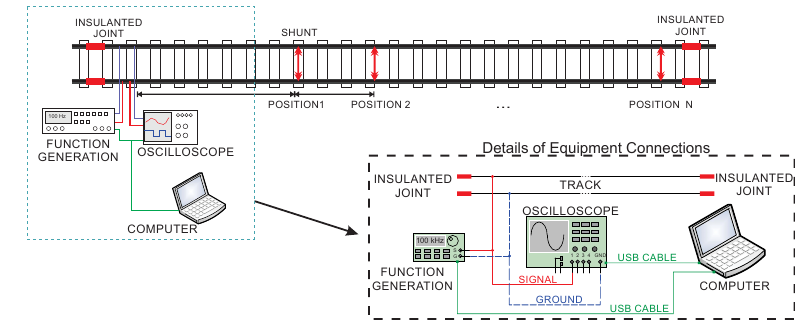
Figure 10. Connection of the proposed system with the track circuit.